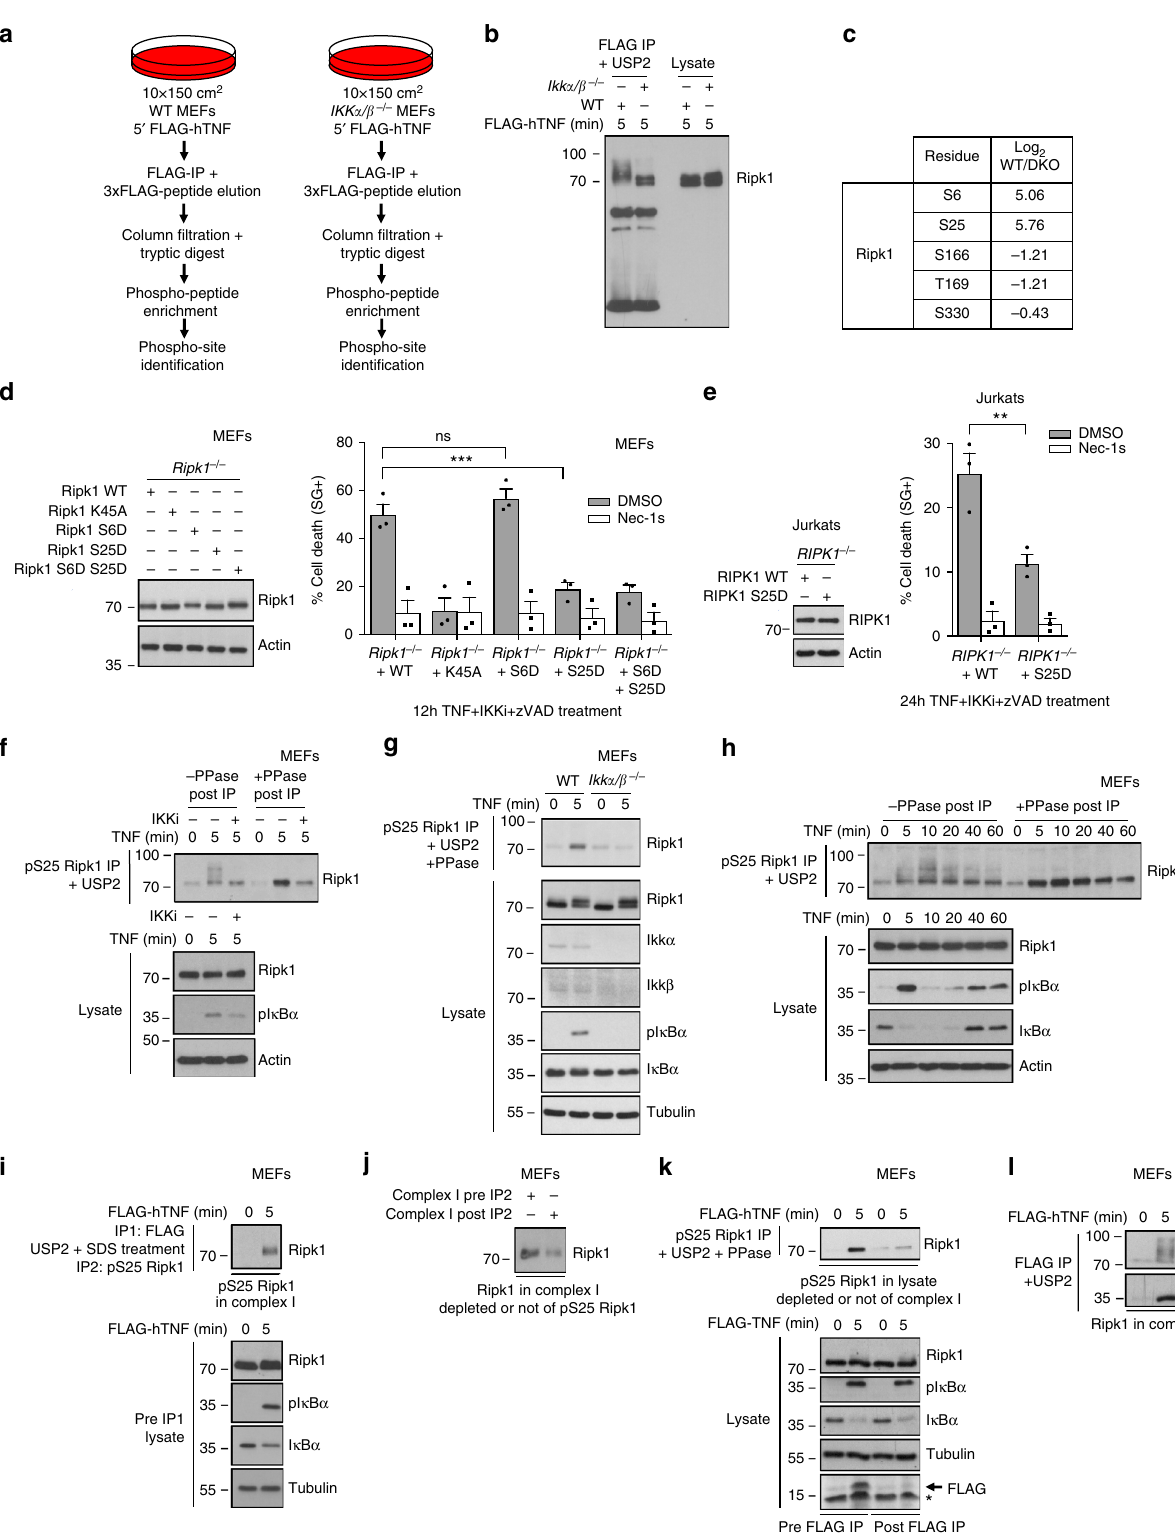
phosphorylation was poorly detected in the pool of RIPK1 non- associated to complex I, which is visualized by analyzing the abundance of pS25 RIPK1 in the lysate prior and after complex I depletion (Fig. 1k – l). This indicates that phosphorylation of RIPK1 on Ser25 predominantly occurs in complex